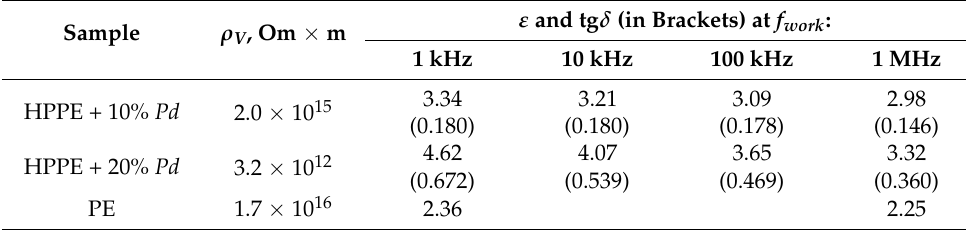
Table 3. The dielectric permeability and the loss tangent for the composites and original PE. Sample